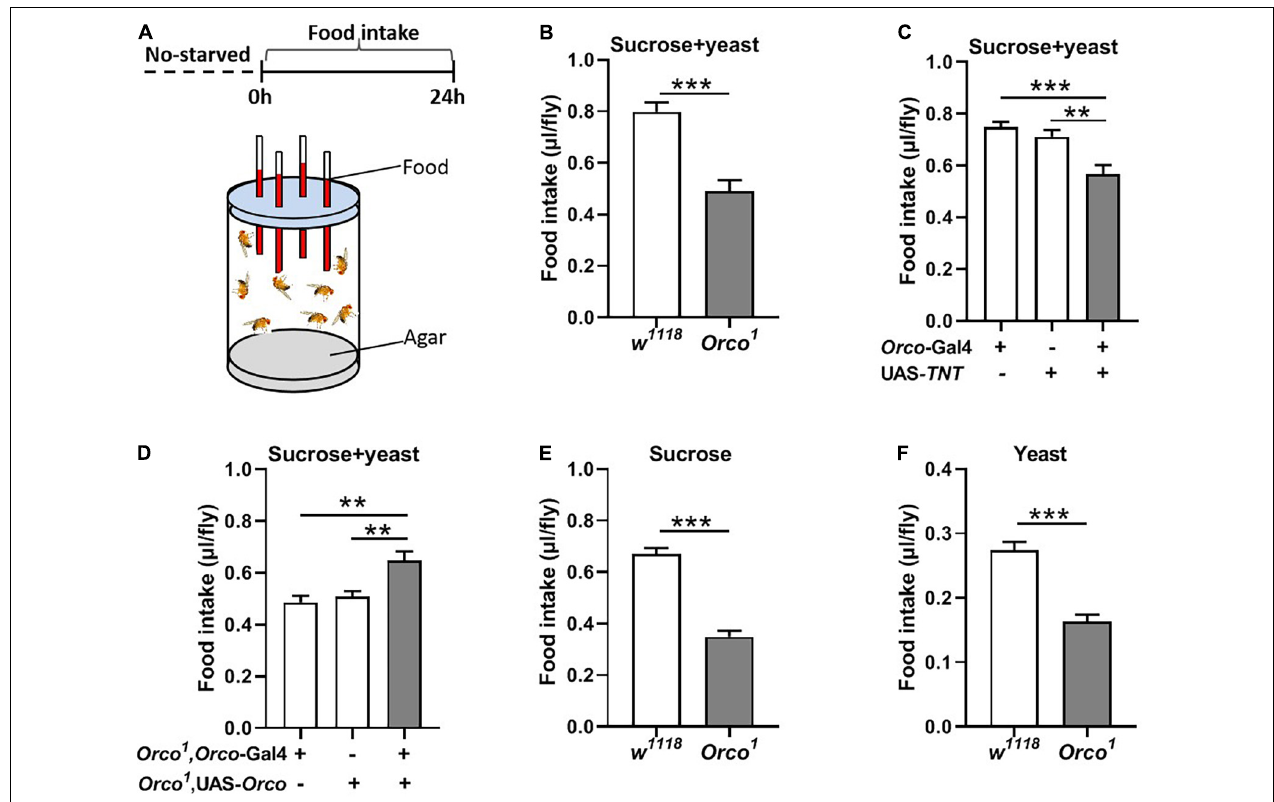
FIGURE 1 | Blocking OSNs decreases the food consumption in non-starved flies. (A) Schematic diagram of the CAFE assay for examining food intake in non-starved flies. (B) Orco 1 mutant flies consumed less sucrose and yeast extract food than control w 1118 flies ( n = 15). (C) Food intake was decreased after blocking OSNs by expressing TNT in Orco -GAL4 driver ( n = 21). (D) Expression of Orco in the OSNs in Orco 1 mutants rescued food (5% sucrose and 5% yeast extract) intake ( n = 15). Orco 1 mutant flies consumed less single sucrose food ( n = 13) (E) and yeast extract food ( n = 17) (F) . Data are represented as mean ± S.E.M. One-sample t -test and one-way ANOVA followed by Dunnett’s post hoc test were used to analyze the difference. ** p < 0.01, and *** p <